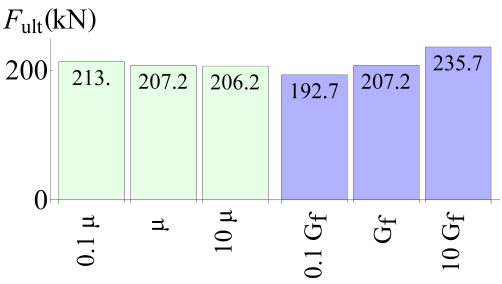
Figure 18. The slant-shear test—results of parametric